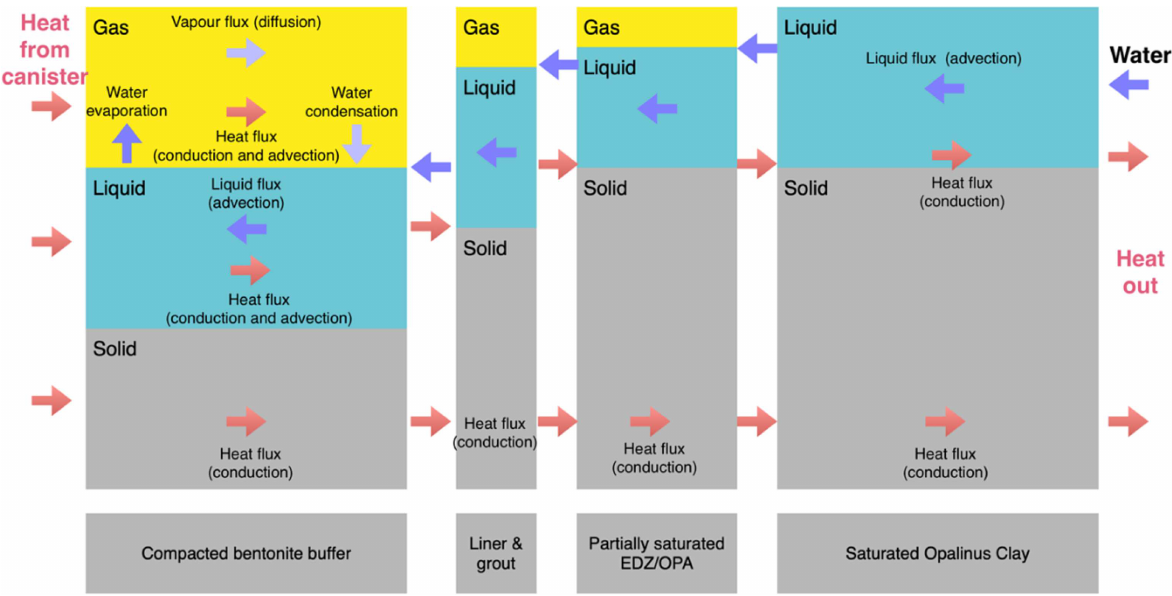
Fig. 5. Simplified schematic illustration of coupled processes associated with vapour transport